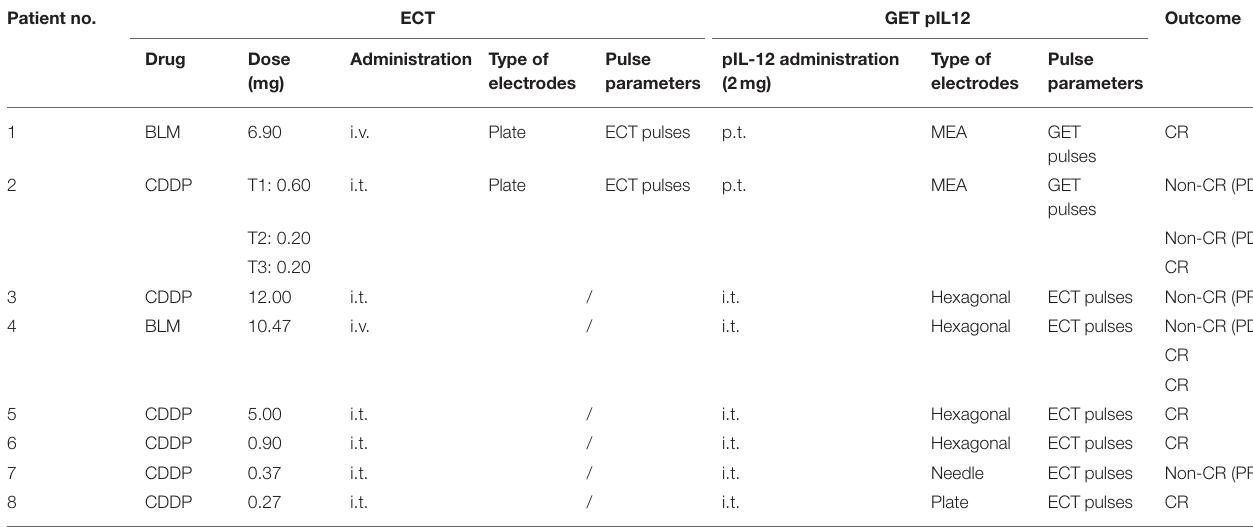
TABLE 2 | Electrochemotherapy (ECT) combined with gene electrotransfer of plasmid DNA encoding canine interleukin-12 (GET pIL-12) treatment regimens (dosages, route of administration, type of electrodes and pulse parameters) and outcome per patient. Patient no.